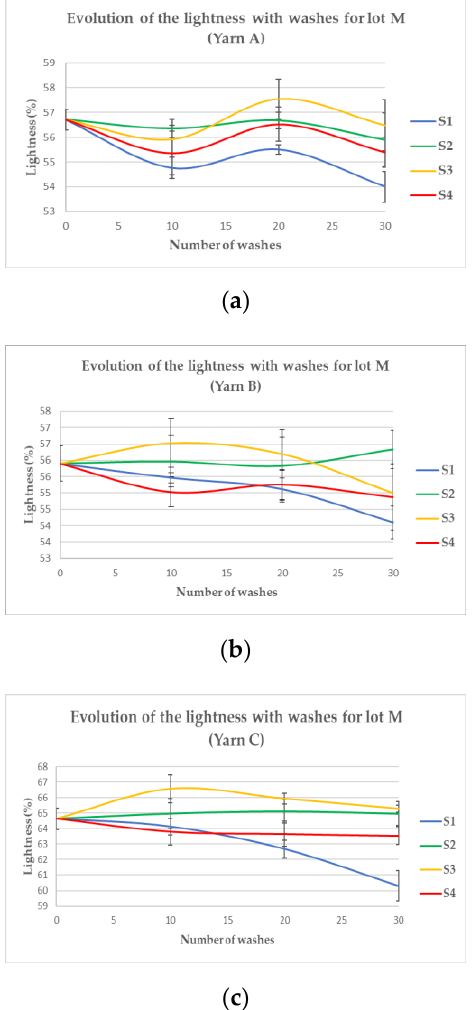
Figure 6. Evolution of the lightness with washes from Lot S, Yarns A ( a ), B ( b ) and C ( c ).